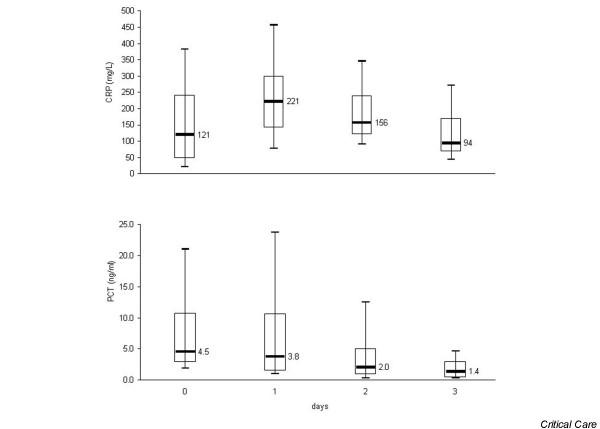
Evolution of CRP and PCT levels over 72 hours. Change in serum levels of C-reactive protein (CRP) and procalcitonin (PCT) from admission (day 0) to 72 hours after the start of treatment.